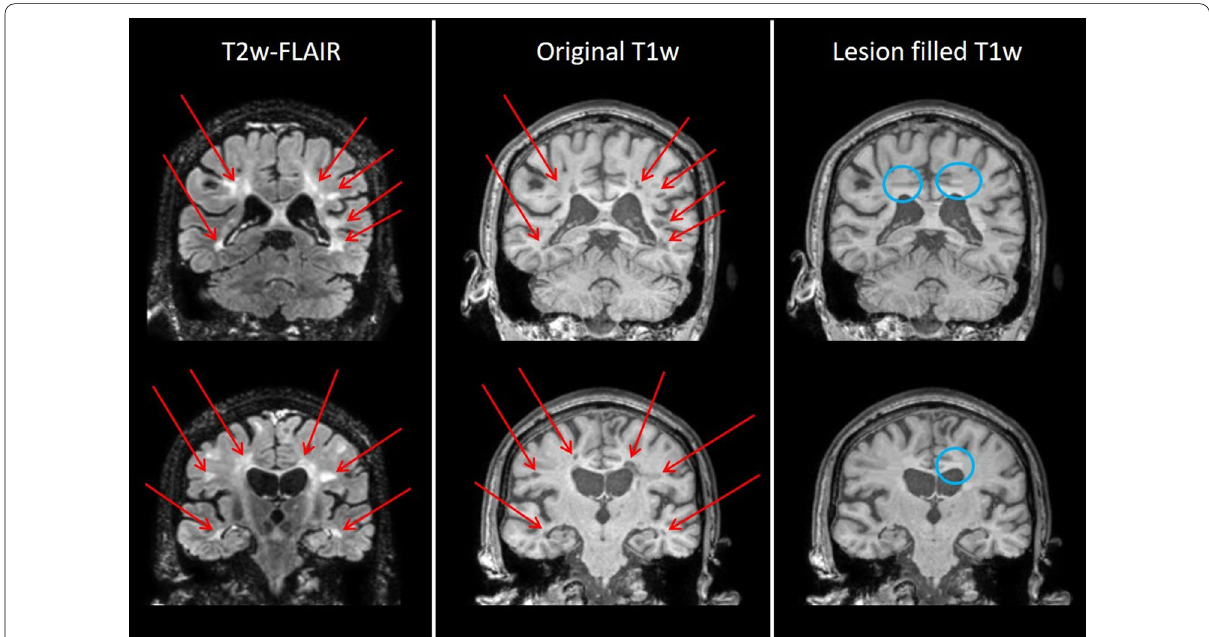
Fig. 3 The effects of lesion filling on T1w MRI illustrating artefacts due to lesion filling. Red arrows depict the locations of the lesions; blue circles depict lesion filling artefacts. The upper row shows some substantial artefacts due to lesion filling, composed of grey matter tissue allocation in the middle of white matter regions, the lower row shows a minor artefact, having blunt white matter